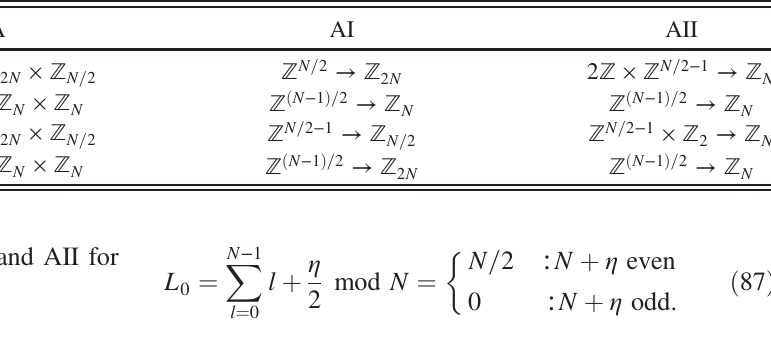
TABLE VI. Classification of noninteracting 0D TIs protected by internal Z operation for classes A, AI, and AII and its reduction in the presence of interaction. This captures the classification of 2D TCIs protected by rotation symmetry for spinful electrons ( η ¼ 1 ) with (AII) or without (A) time-reversal symmetry and for spinless electrons ( η ¼ 0 ) with (AI) or without (A) time-reversal symmetry. We can also read from here the classification of 3D TCIs without surface states protected by inversion ( N ¼ 2 , η ¼ 0 ) or rotoinversion for spinful electrons ( η ¼ 1 ) with (AII) or without (A) time-reversal symmetry and for spinless electrons ( η ¼ 0 ) with (AI) or without (A) time-reversal